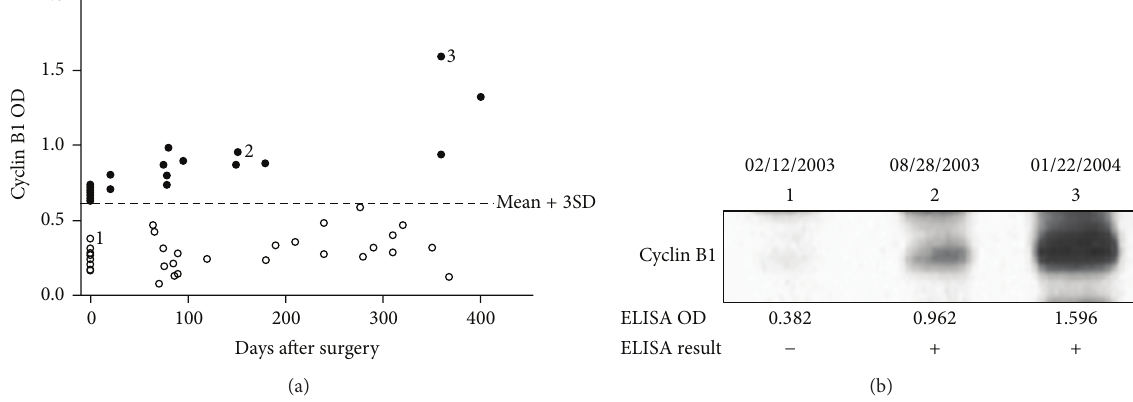
Figure 2: (a) Distribution of cyclin B1 antibody responses in different time points before and after surgery treatment. Anti-cyclin B1 antibody levels (OD values) in the 55 samples from 18 PCa patients were shown. Nineteen serum samples that are positive for anti-cyclin B1 are shown as filled black dots. The other samples are shown as unfilled circles. (b) Western blotting result of serial sera from a representative patient. Lane 1 is the sample before surgery and lanes 2 and 3 are ones after surgery.